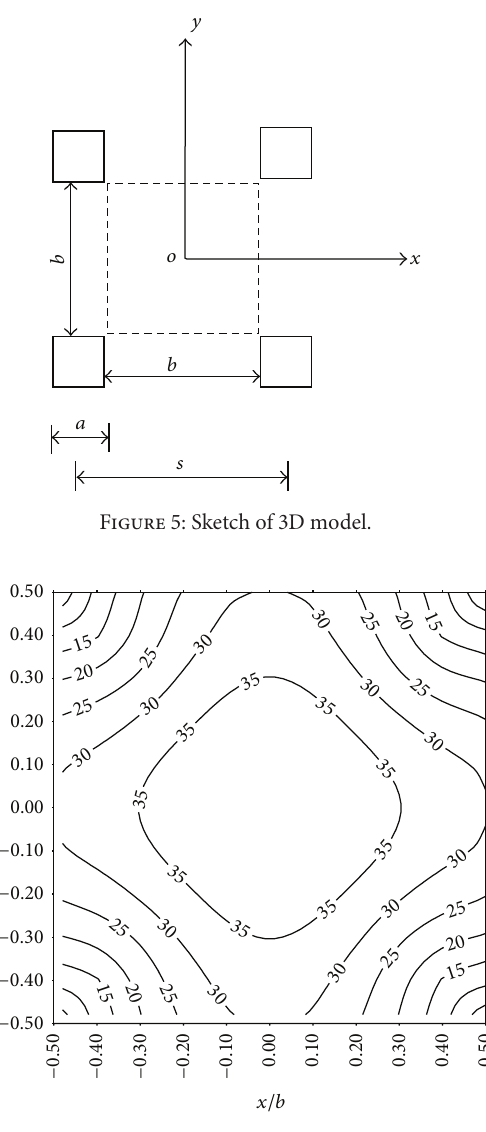
Figure 6: Computed geosynthetic deflection ( 𝑝 = 50 kPa, 𝑏 = 1.5 m, 3D).